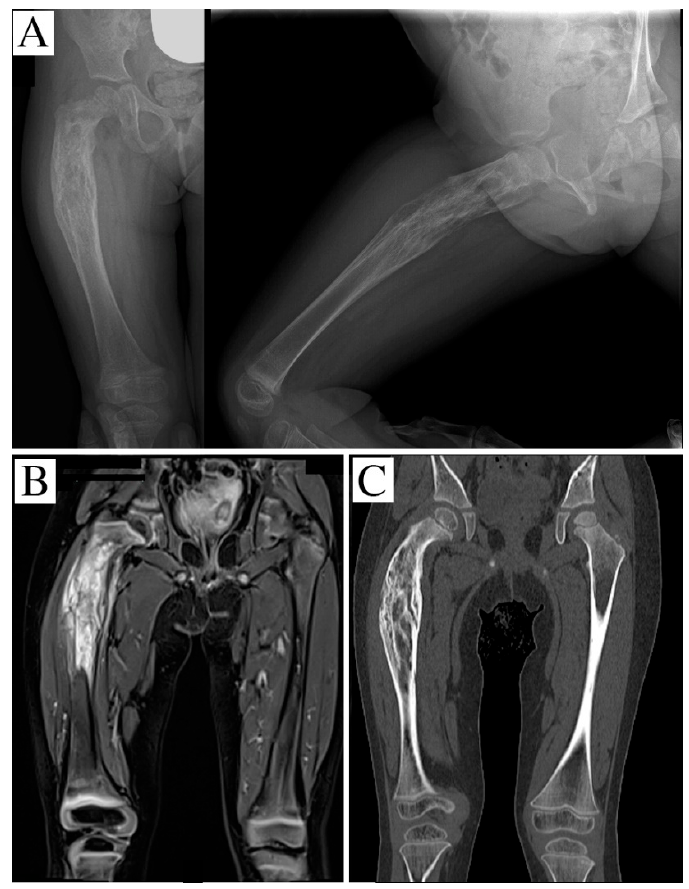
Figure 1. ( A ) an X ‐ ray showing an osteolytic and apparently well ‐ defined lesion of the proximal and middle third of the right femur; the segment is bent with onion ‐ skin periosteal reaction; ( B ) middle third of the right femur; the segment is bent with onion-skin periosteal reaction; ( B ) STIR- STIR ‐ weighted coronal ‐ MRI reconstruction, evidencing permeative behavior and an intense weighted coronal-MRI reconstruction, evidencing permeative behavior and an intense edema. ( C ) CT edema. ( C ) CT scan showing the geographic osteolysis. scan showing the geographic